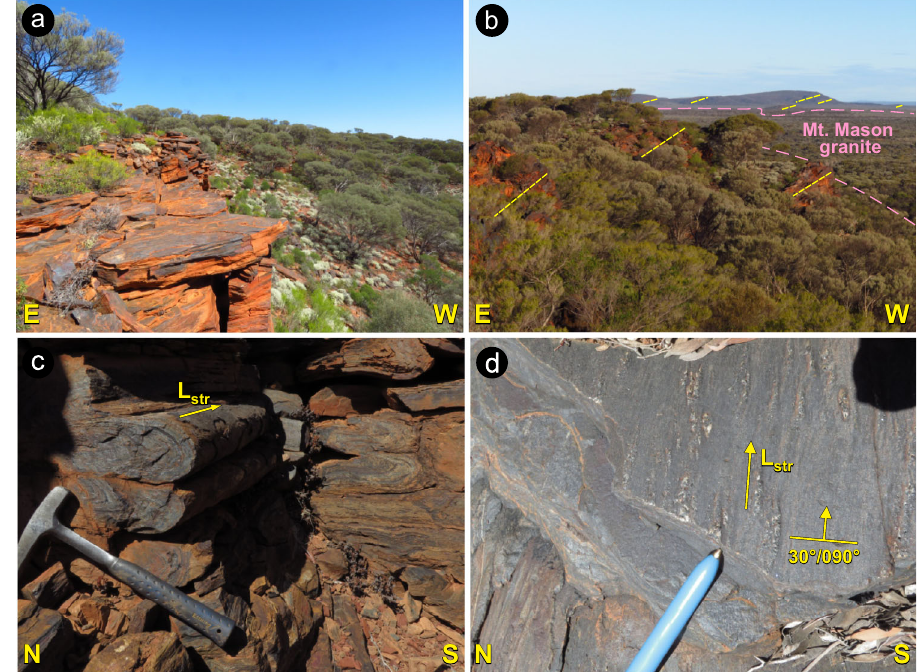
Fig. 2 | Prominent outcrop-scale features of the Mount Ida greenstone belt. Outcrops location shown in Fig. 1b. a Approximately 20m-thick BIF (Banded Iron Formation) ridge, showing gently east-dipping transposed bedding. b Panoramic viewfromMtMason,lookingsouthward.Interlayered,weathering-resistantBIFand basaltsareassociatedwithaprominenttopographicscarp,100 – 200mhigherthan the fl at landscape at west, dominated by the more erodible granite. The